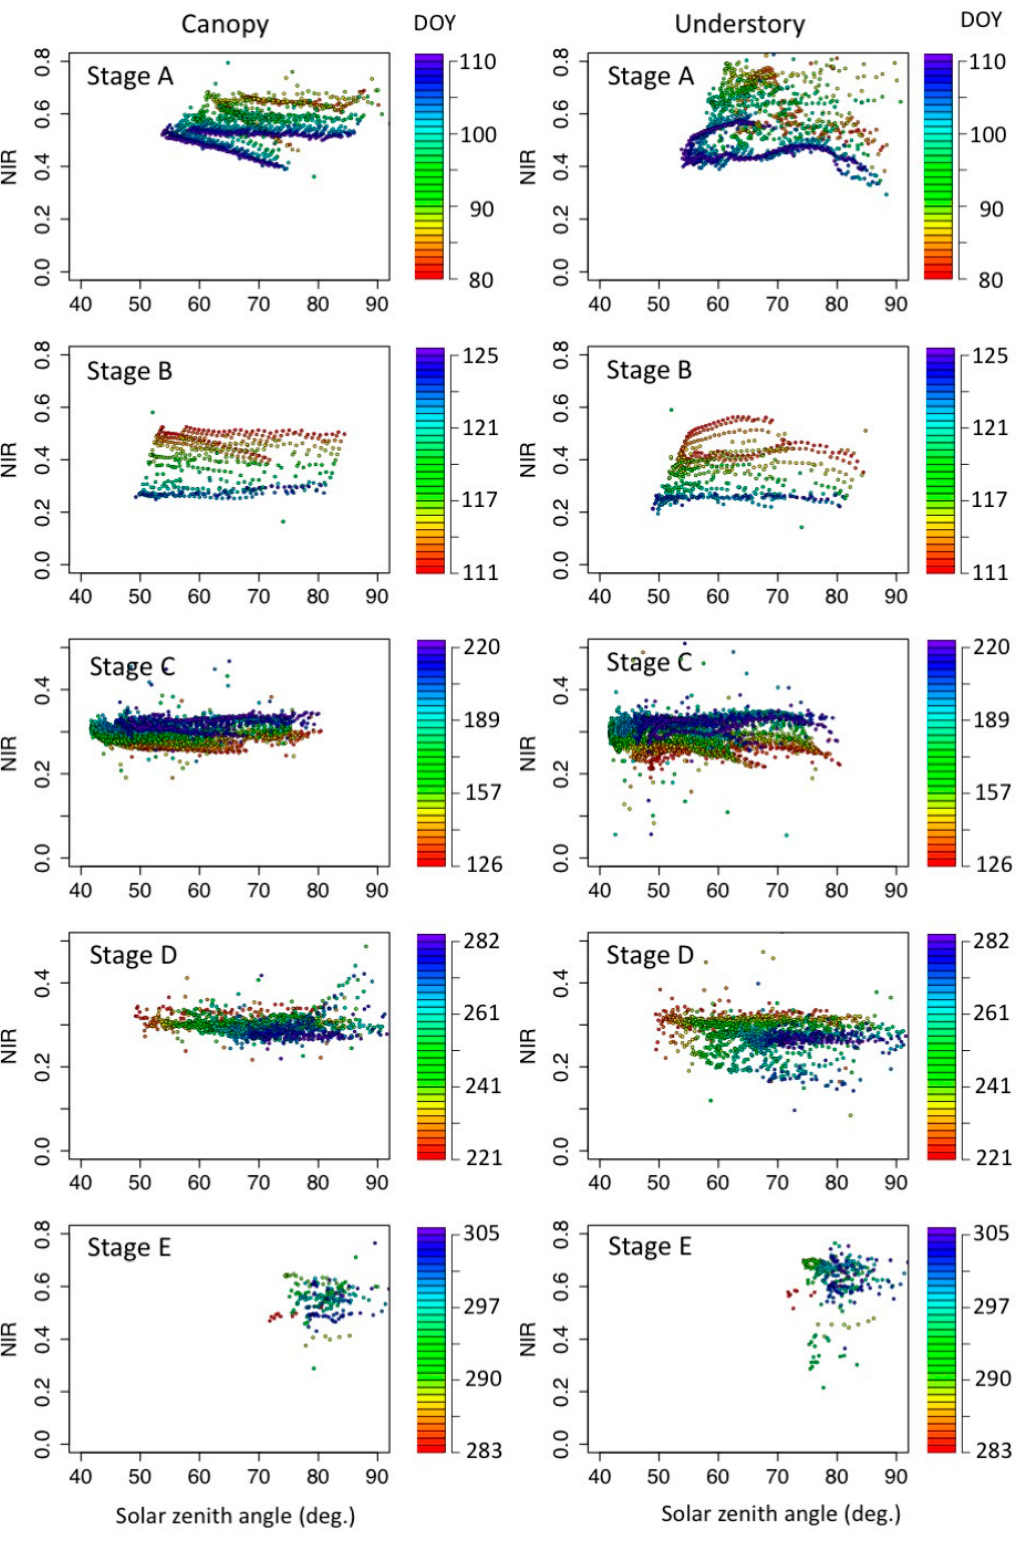
Figure A3. Solar zenith angle dependency of NIR reflectance in five phenological stages. The definition of phenological stages are shown in Figure 2. Left : canopy scale NIR reflectance (measured at the top of the tower). Right : understory measurements. Colors on the plotted circles denote the day of the year (DOY) of the measurements.